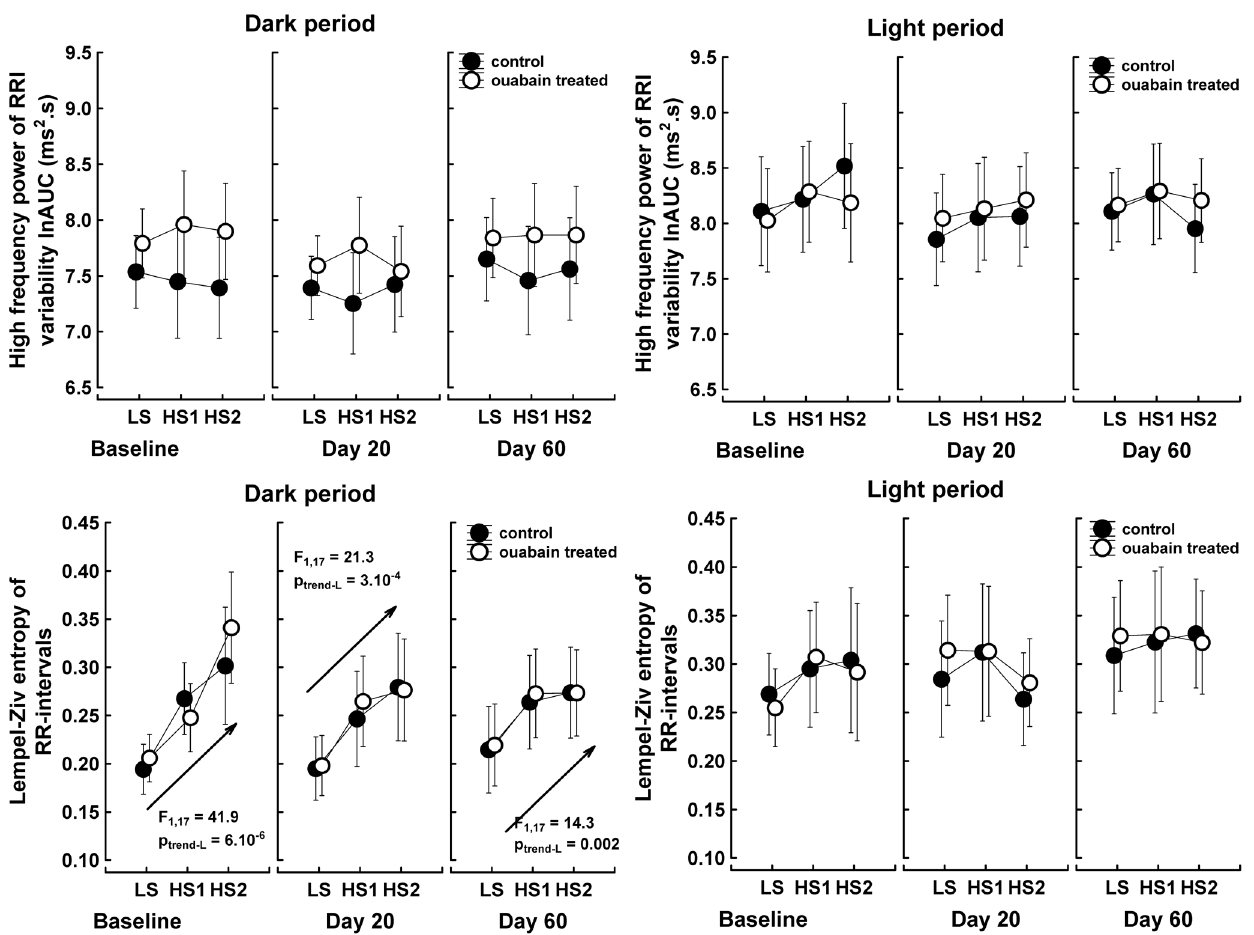
Figure 6. High-frequency power and Lempel-Ziv entropy of the RR-interval variability changes in response to increased NaCl intake. The data points represent the means of three 35-min intervals selected in the middle of the dark and light periods; the vertical bars denote 95% confidence intervals, n=9 control rats; n=10 ouabain-treated rats. LS, low salt intake; HS1, 1 st day of high salt intake; HS2, 2 nd day of high salt intake. Baseline, salt test performed before the implantation of the ouabain pellets; Day 20, rats were treated for 27–29 days with 63 m g ouabain/kg/ day, Day 60, rats were treated for 40 days with 63 m g ouabain/kg/day and then for 27–29 days with 324 m g ouabain/kg/day. Data were analyzed with repeated measures MANOVA and the multivariate Wilk’s test in a 2 (group) x 3 (time/ouabain treatment) x 3 (salt intake) x 2 (illumination) between- within design. The arrows denote the linear trend analysis common for both groups. F, univariate F-test value, subscripts are the degrees of freedom; P trend , probability that a linear relationship between time and analyzed parameters is due to chance.